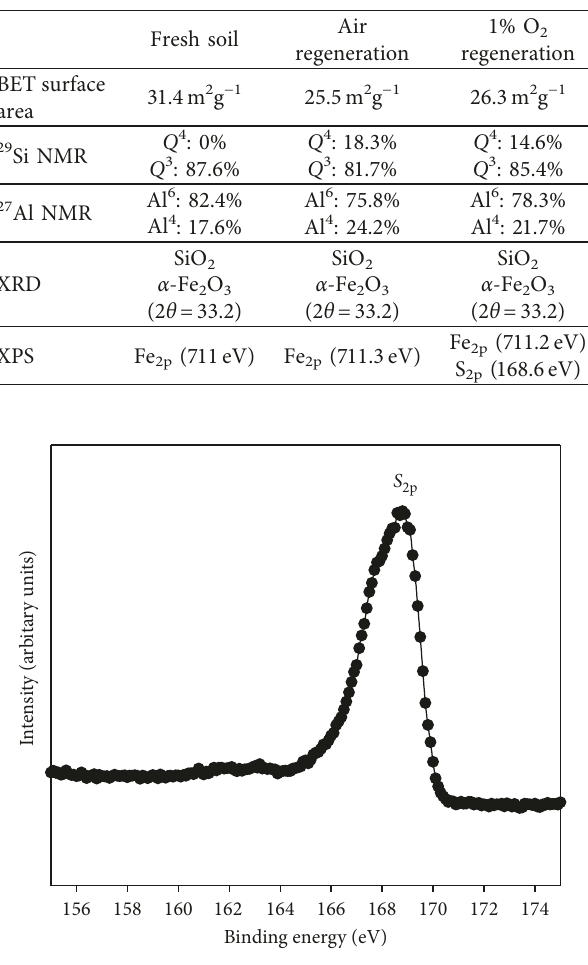
Figure 3: XPS spectrum analysis of S soil after diluted 1% O 2 regeneration.